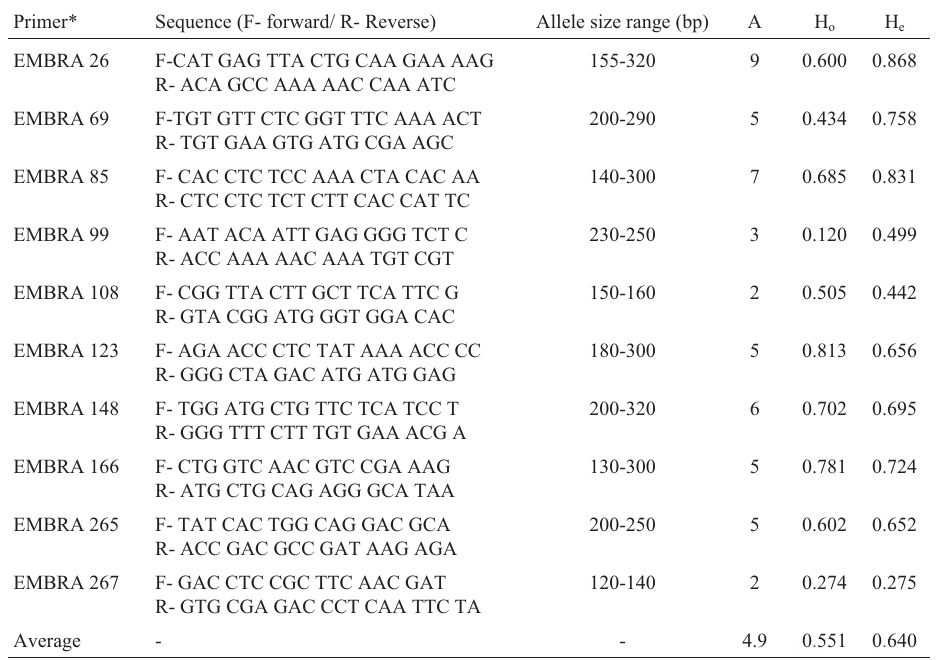
Table 2 - Sequence of the 10 used pairs of primers developed for Eucalyptus genera, allele size range, number of alleles per locus (A), observed heterozygosity (H o ) and expected heterozygosity (H e ) of amplified microsatellite loci in Acca sellowiana